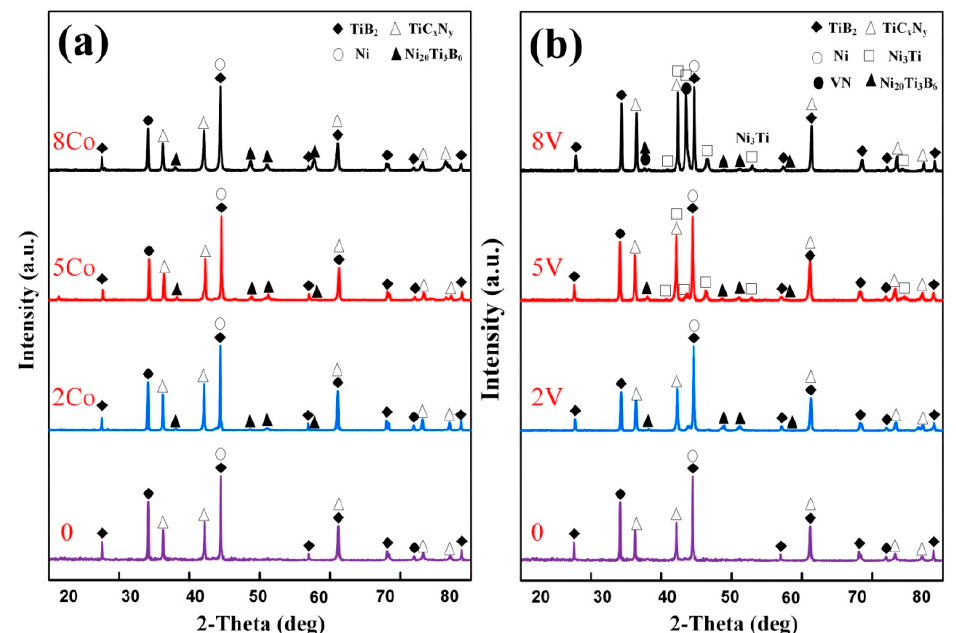
Figure 3. X-ray diffraction patterns for the (TiC x N y –TiB 2 )/Ni cermets. ( a ) (TiC x N y –TiB 2 )/Ni cermets with different Co contents (Co content from bottom to top is 0, 2, 5 and 8 wt.%, respectively). ( b ) (TiC x N y –TiB 2 )/Ni cermets with different V contents (V content from bottom to top is 0, 2, 5 and 8 wt.%, respectively).